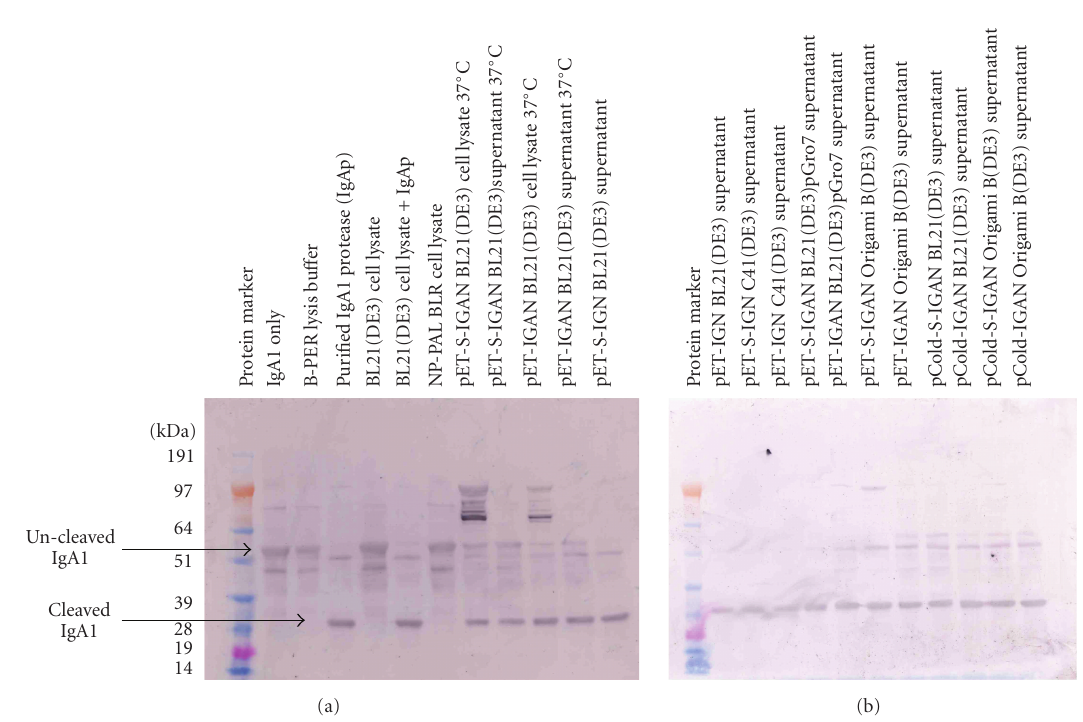
Figure 4: Expressed soluble IgA1 proteases were active. IgA1 was incubated with cell lysates or soluble supernatant at 37 ◦ C overnight. SDS-PAGE (reduced condition) and Western blotting with anti-IgA Ab were employed to detect the cleavage. IgA1 was cleaved by soluble supernatant (or cell lysate) induced at 12 ◦ C with 0.4mM IPTG (except some were induced at 37 ◦ C with 1mM IPTG for 3